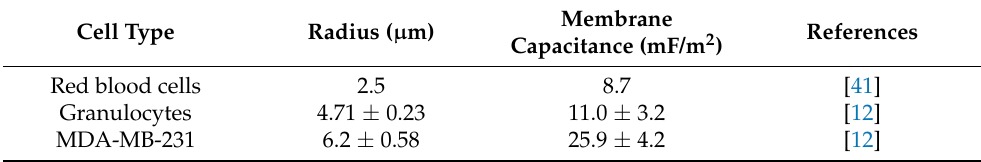
Table 2. The types and properties of selected